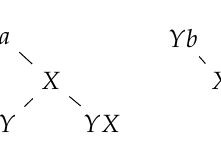
Figure 5. The tree group following the application of ( λ , Y → b , λ )